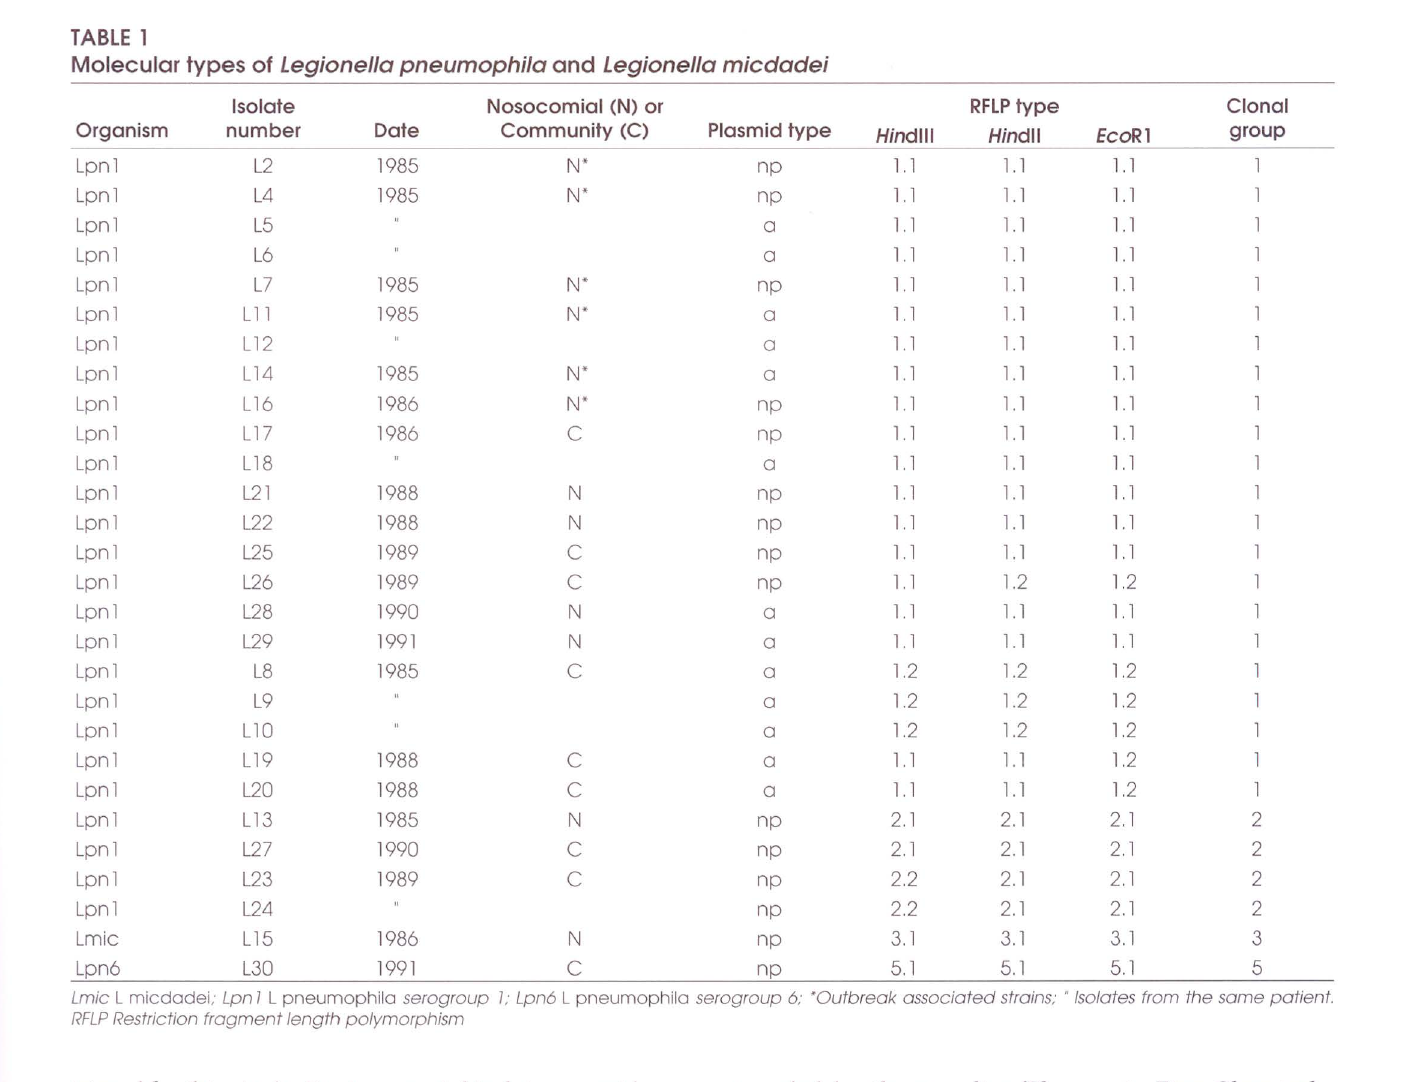
Molecular types of Legione/la pneumophila and Legionella micdadei